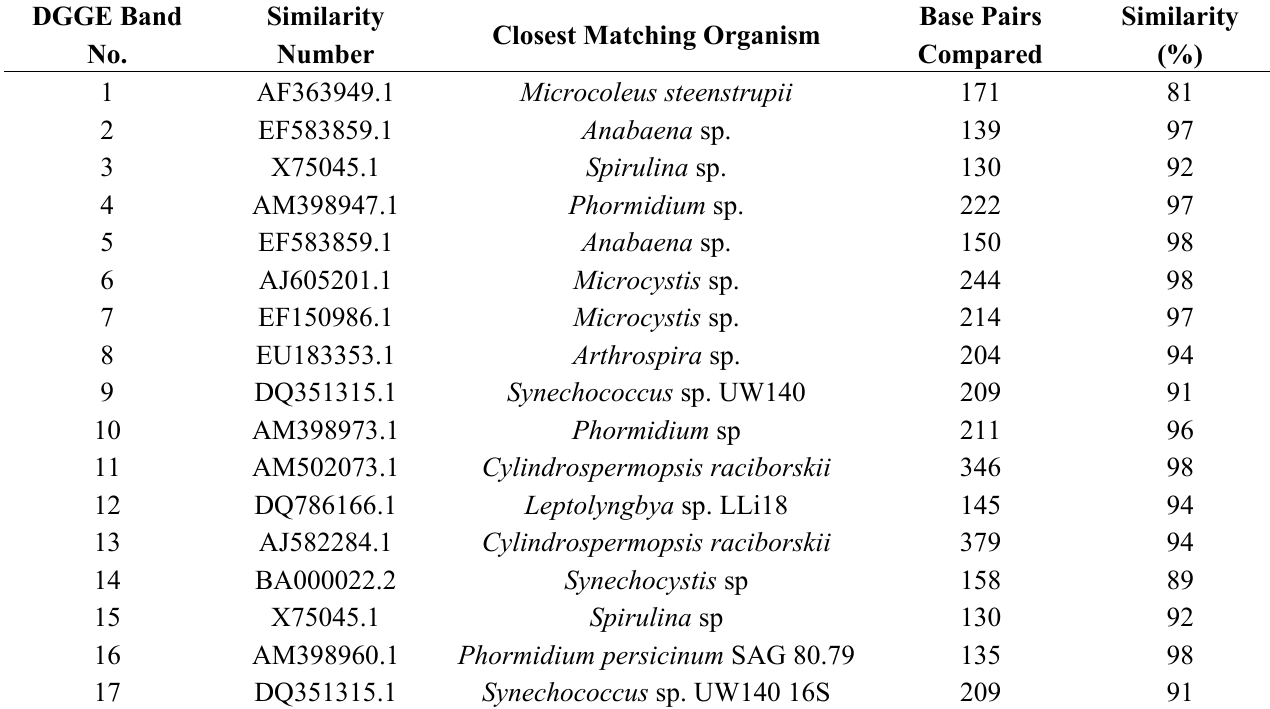
Table 3. The sequencing result of bands in Figure 2.